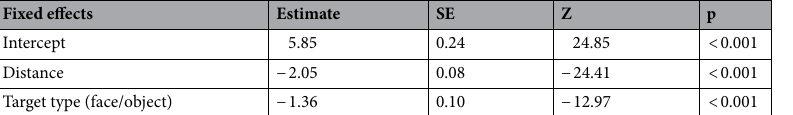
Table 1. The best fitting GLMM for predicting the binary decision of cursor location in Experiment 1. The reference level for Target Type was the face